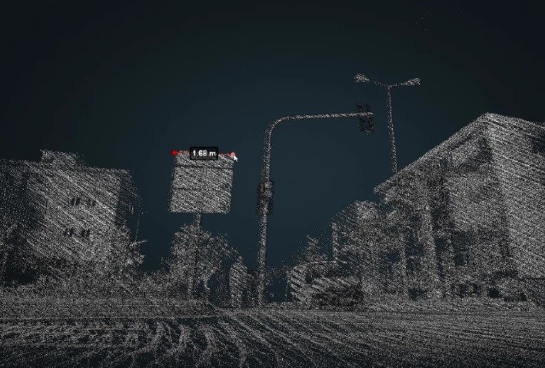
Figure 15: A part of Istanbul LoD2 city models with 3D mosques and surroundings